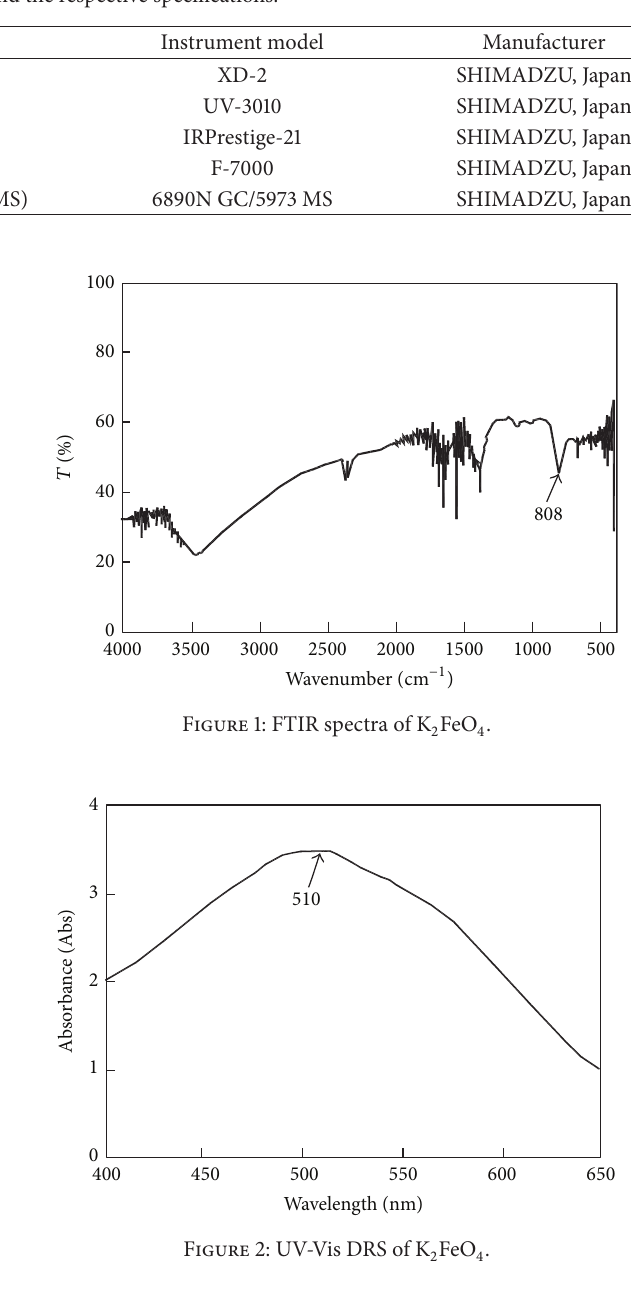
Table 2: Main equipment and the respective specifications.